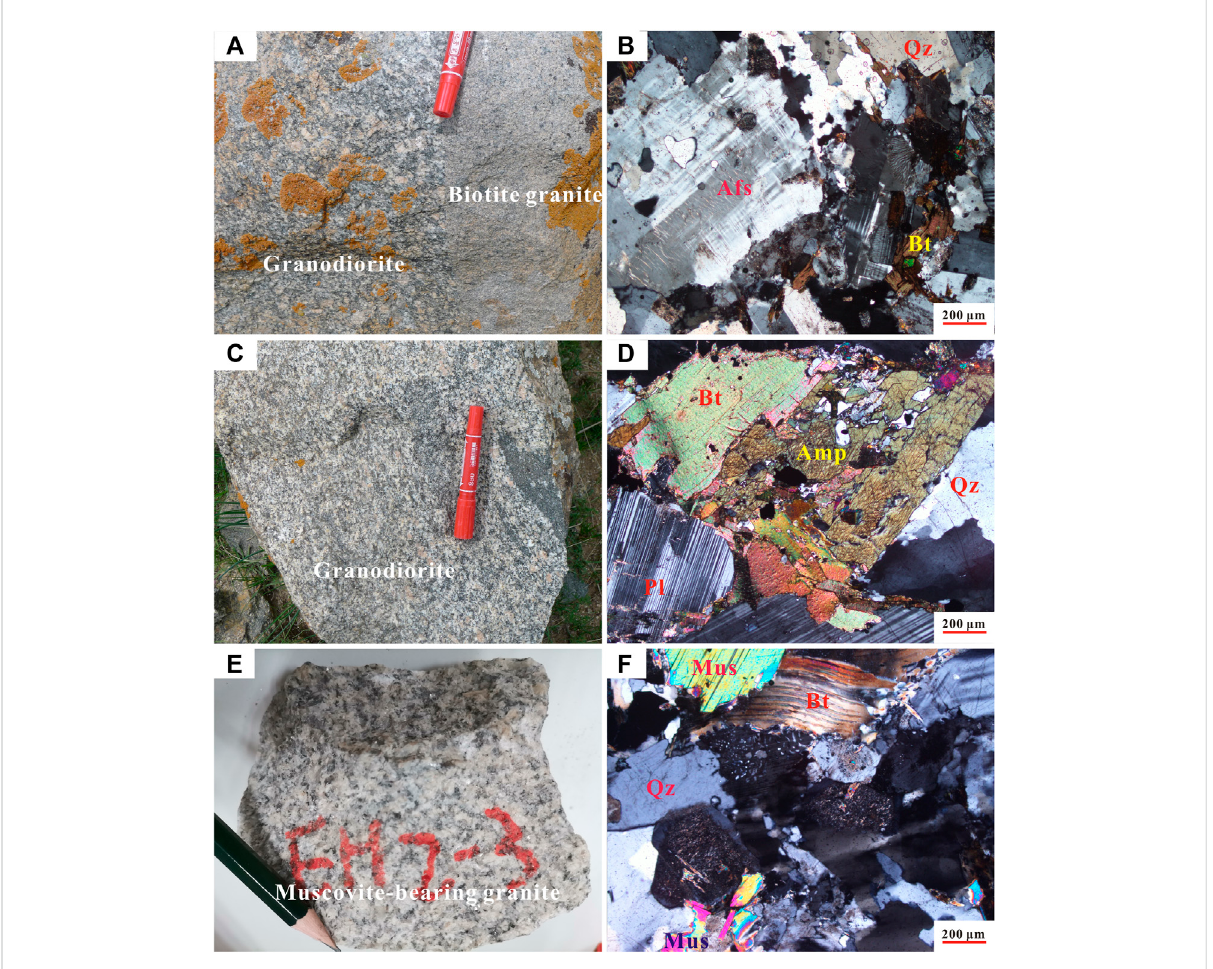
FIGURE 3 Macroscopic and thin section images of rocks from the Gahai and Erhai plutons (A) Sharp contact between the granodiorite and biotite granite within the Gahai pluton; (B) Gahai biotite granite (crossed nicols); (C) Gahai granodiorite bearing microgranular ma fi c enclaves; (D) Gahai granodiorite (crossed nicols); (E) Erhai muscovite-bearing granite; (F) Erhai muscovite-bearing granite with granophyric texture (crossed nicols). Mineral abbreviation: Qtz, quartz; Afs, alkali-feldspar; Pl, plagioclase; Bt, biotite; Mus , muscovite; Amp,